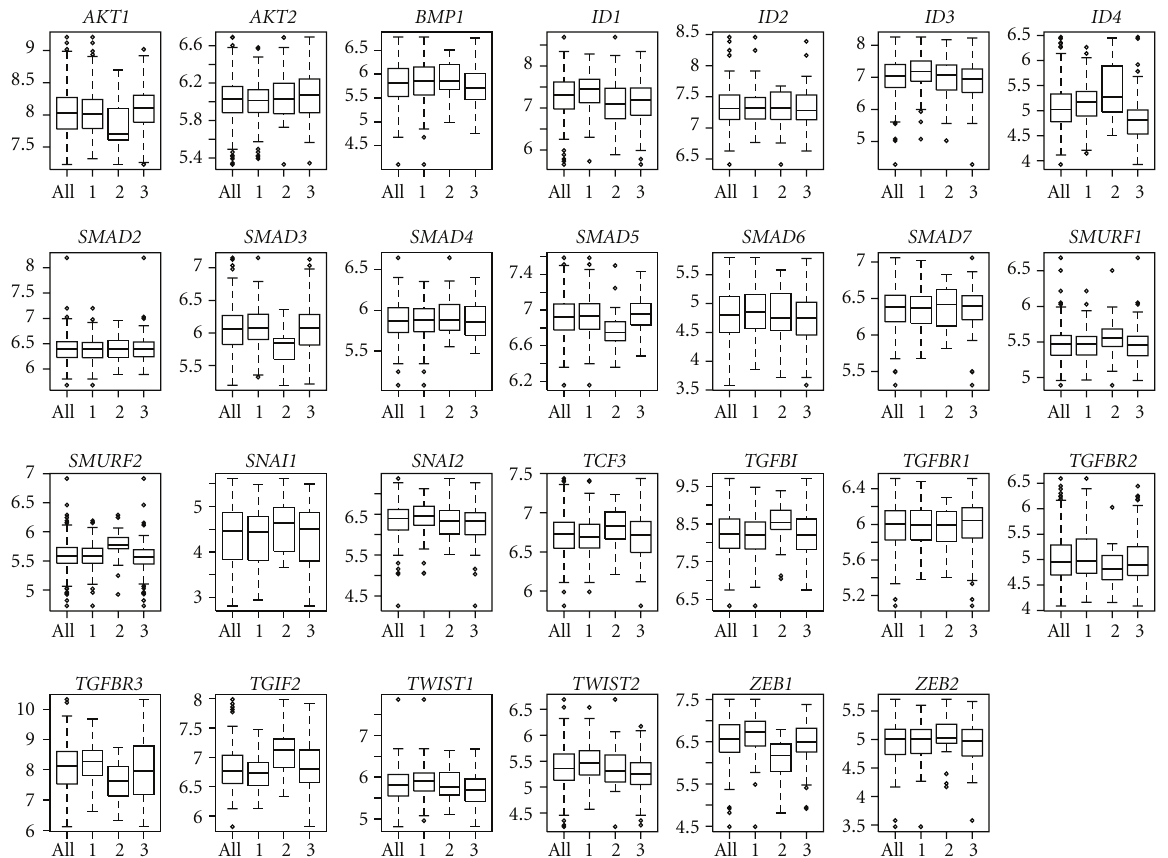
Figure 7: Boxplots of the genes associated with EMT in the three main clusters identified by unsupervised hierarchical cluster analysis using the subset of genes coding for luminal and basal markers, HER-2 and